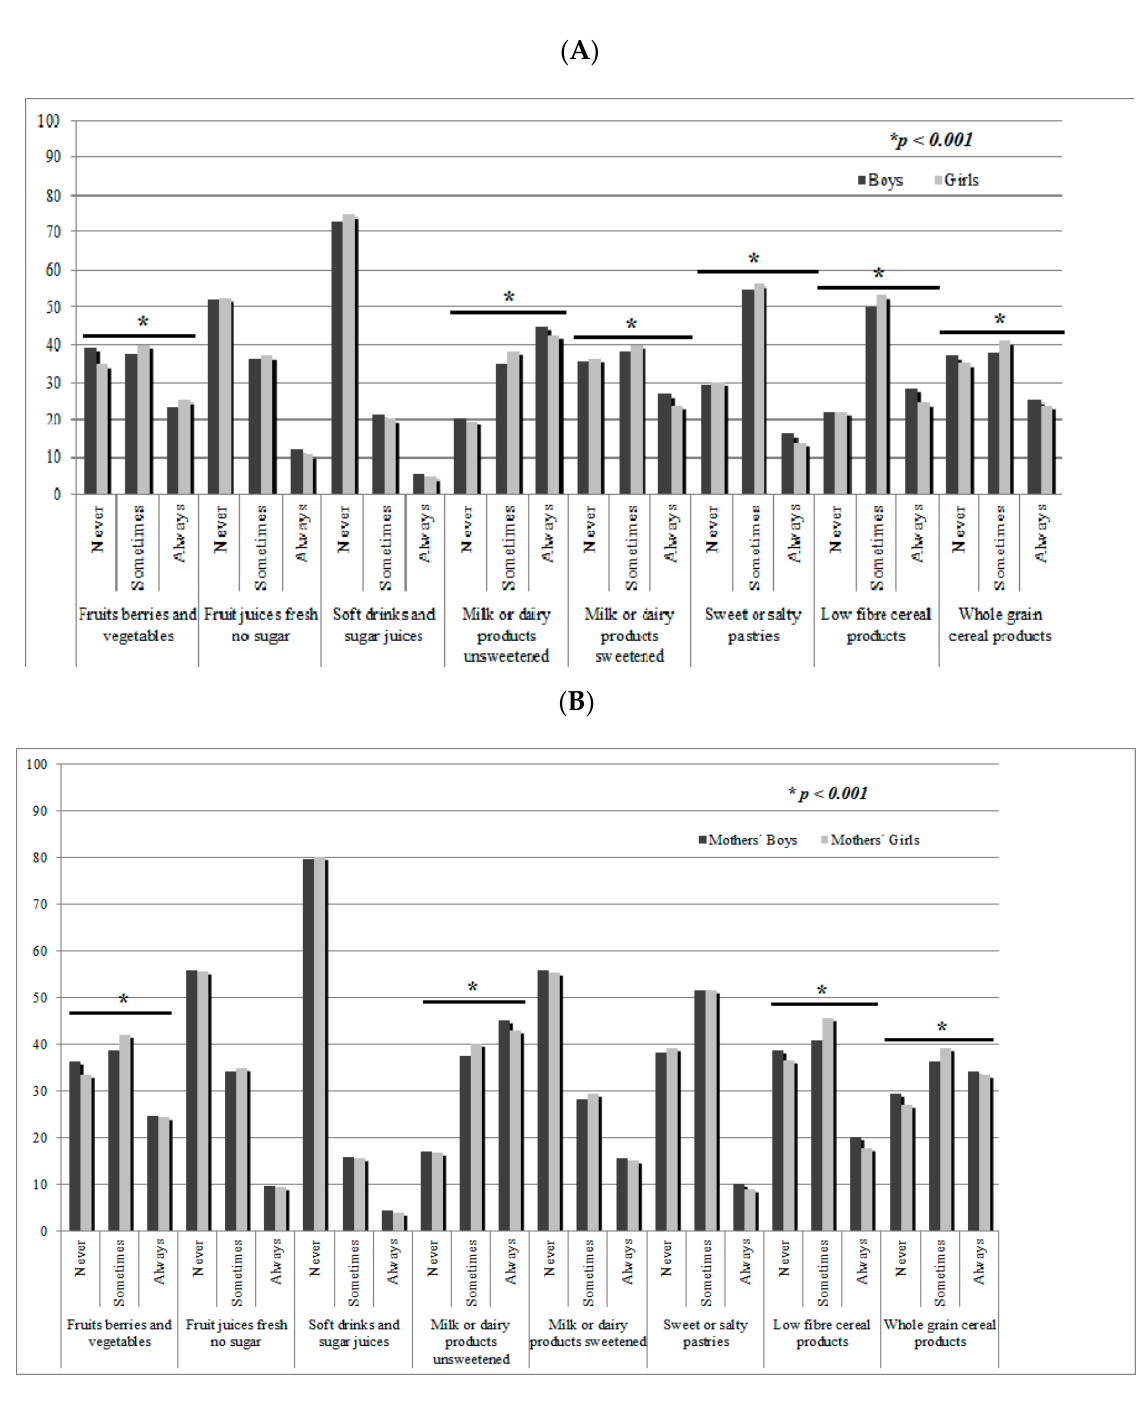
Figure 1. Description of food and beverages consumed at breakfast in children ( A ) and their mothers ( B ) who occasionally or usually consumed breakfast by gender. * p values from chi-square indicate statistical significance between genders. Frequency of food and beverage groups’ consumption: Never (0 times/week), Sometimes (1–4 times/ week), Always (5–7 times/week).